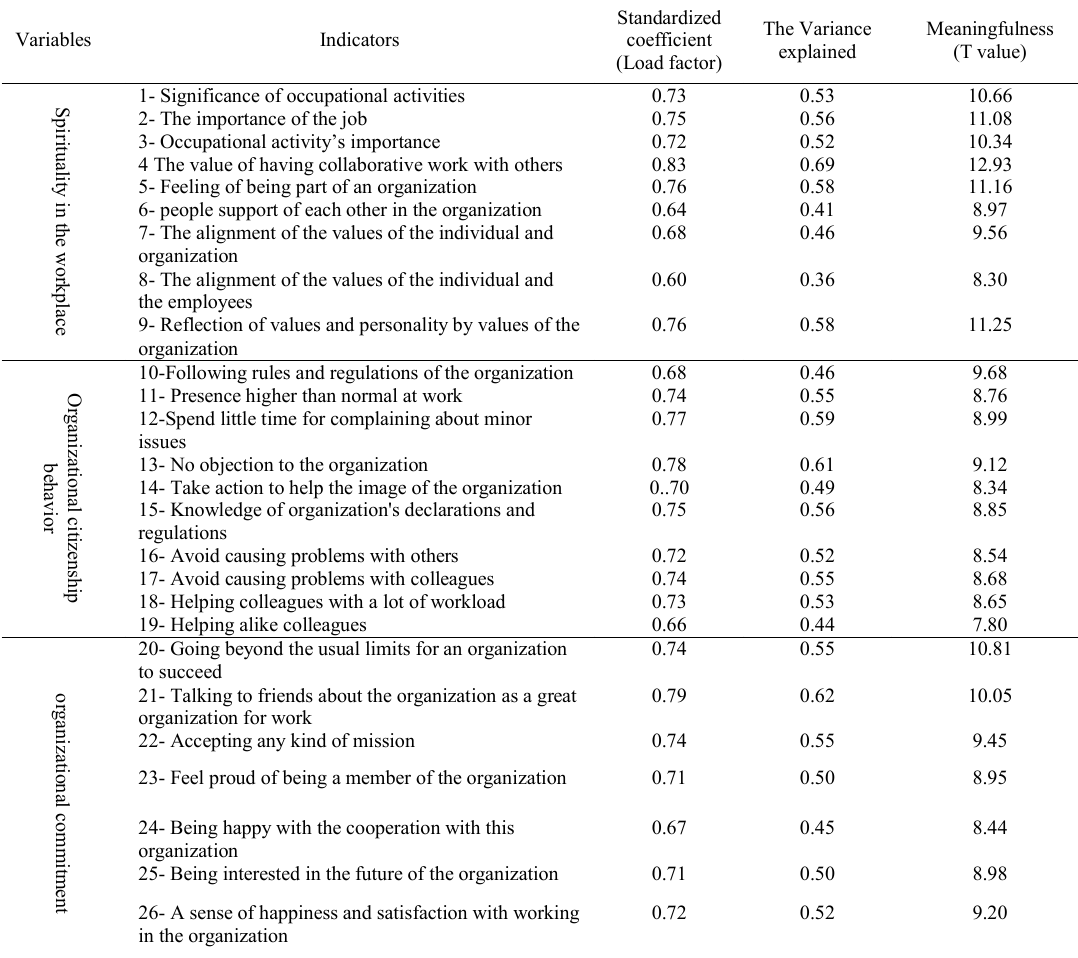
Table 2: Indicators related to each variable and their factor